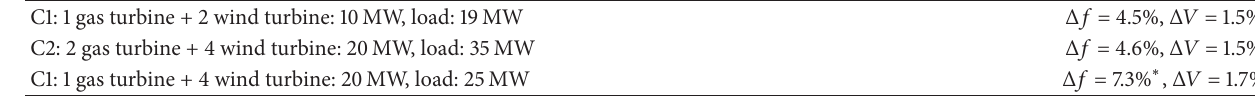
Table 4: Frequency/voltage deviations ( Δ𝑓 / Δ𝑉 ) during loss of all wind power.